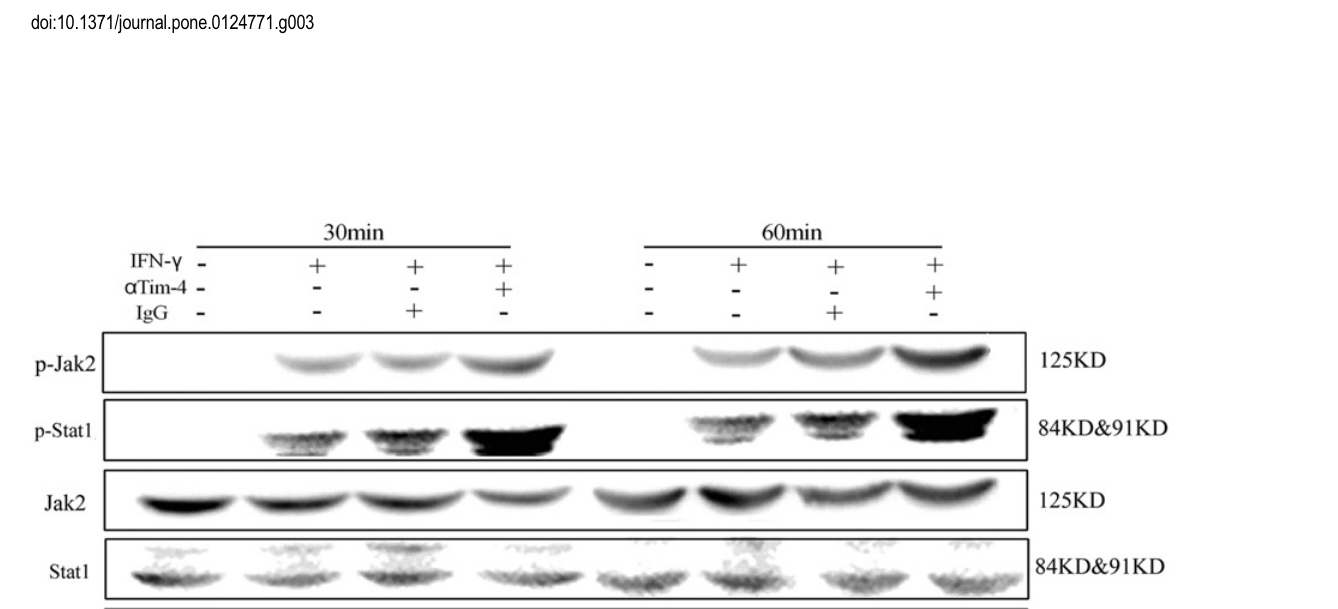
Fig 3. Tim-4 inhibited NO production by NF- κ B signaling pathway. RAW-pcDNA3-Tim-4 and RAW-pcDNA3 cells were stimulated with LPS for the times indicated and western blot was used to detect phosphorylation of NF- κ B p65 (A). Production of NO in LPS-activated RAW264.7 was detected before or after treatment with NF- κ B inhibitory ligand (B). Peritoneal macrophages were pre-treated with goat anti-mouse Tim-4 antibody or control IgG at 5 μ g/ml for 1 h, and then stimulated with 100 ng/ml LPS for 30 min. Cells were harvested for western blot (C). Production of NO in LPS-stimulated peritoneal macrophages with or without anti-Tim-4 pretreatment was detected before or after application of NF- κ B inhibitory ligand (D). These experiments were repeated at least 3 times. Error bars represent the standard deviation from 4 independent cultures from 4 mice. A p value (student ’ s t- test) relative to the control cells of less than 0.01 is indicated by ** . ns represents a p value greater than 0.05.